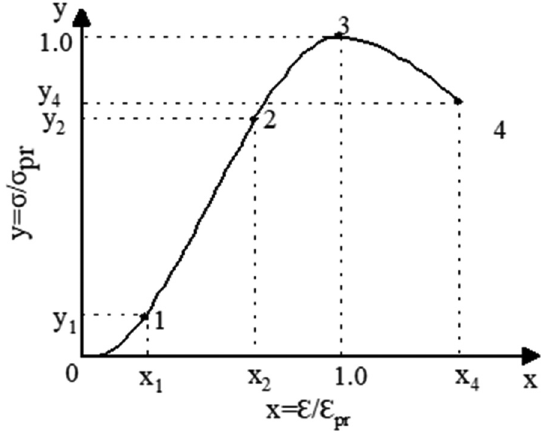
Figure 9: Typical stress – strain curve of raw soil